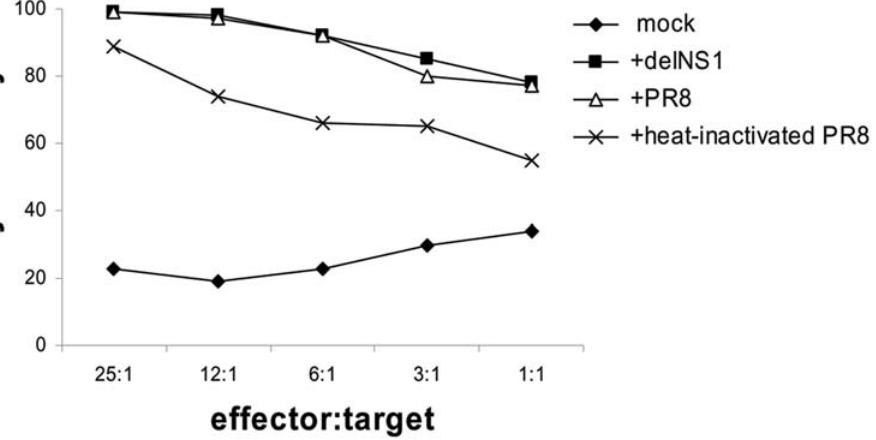
Figure 1. Induction of an anti-tumor cytotoxic immune response by PBMCs infected with influenza A variants. PBMCs were mock- treated or infected with delNS1 virus, wt PR8 and heat-inactivated wt PR8 (m.o.i.=0.02) and were incubated for 24 hours. Then PBMCs were co- cultured with the target A375 cells for 24 hours and cytotoxicity was assessed thereafter. One representative result out of three independent experiments, each performed with PBMCs derived from a different donor, is shown.